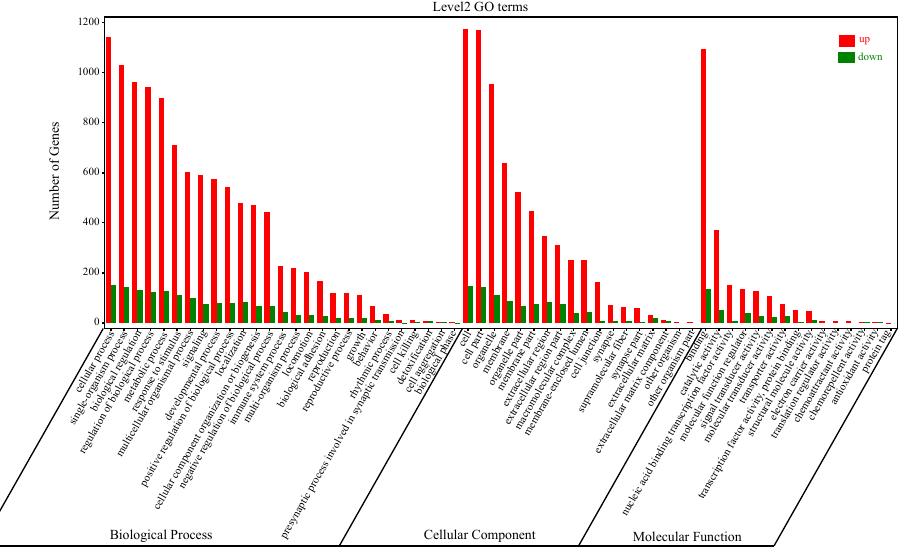
Figure 2. GO analysis of the 1568 DEGs at level 2. Genes were classified into biological processes, cellular components, and molecular functions. The y-axis shows the number of genes in each category. The red bars represent up-regulated genes, and green bars represent down-regulated genes.